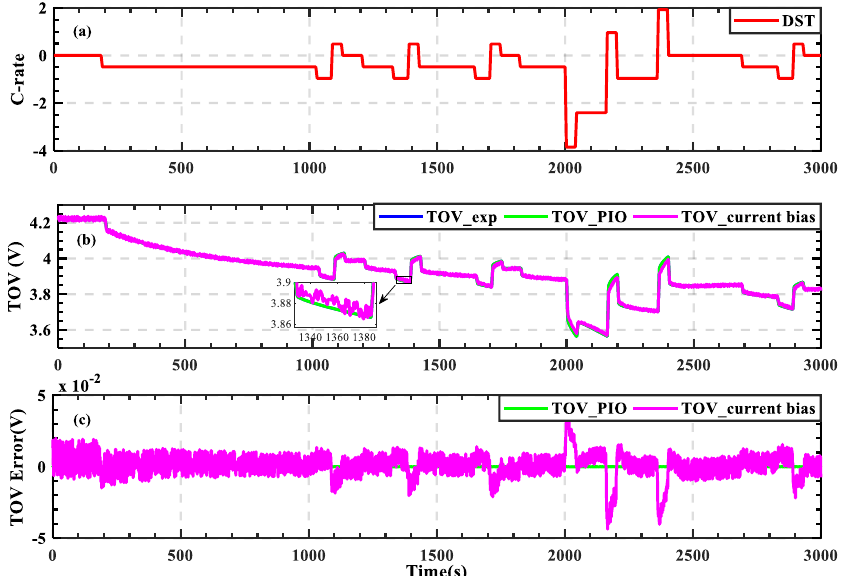
Figure 5. Estimation results of the model TOV considering current bias under DST condition. ( a ) DST profile, ( b ) Results of TOV, ( c ) Errors of TOV.